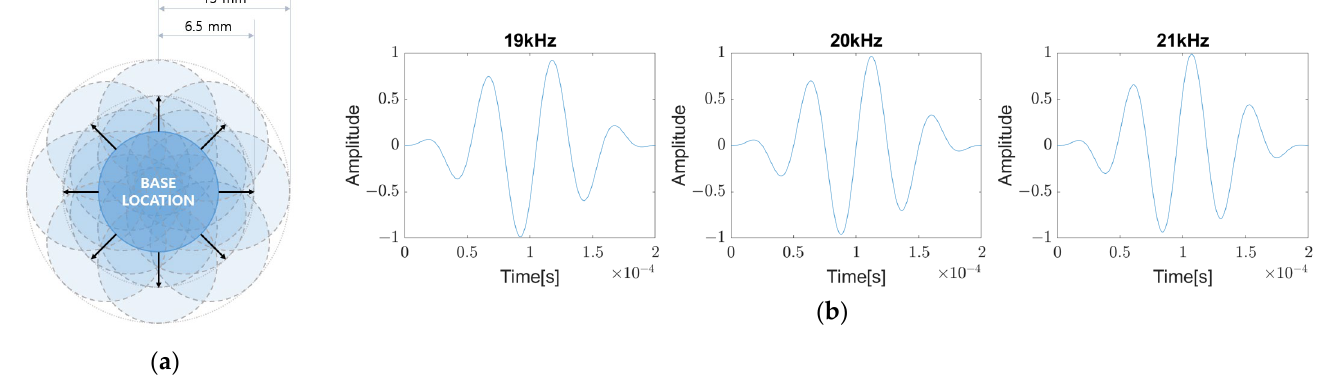
Figure 17. ( a ) Multiple defect locations to train for one standard position; ( b ) excitation signal for each frequency.